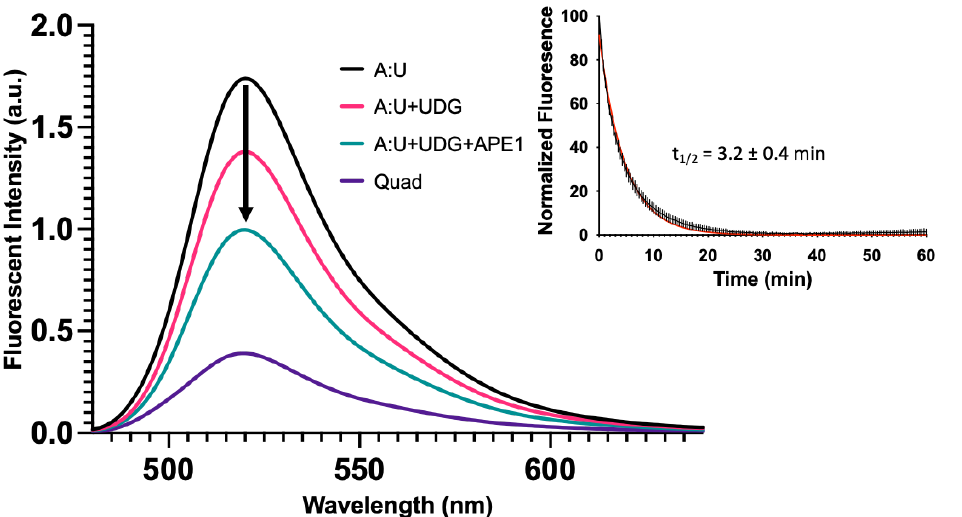
Figure 6. Base excision repair promotes quadruplex formation. In Figure 5, we demonstrated with synthetic oligonucleotides that the presence of a complementary strand containing an abasic site or gap destabilized the duplex and promoted quadruplex formation. Here, we simulated the same process but enzymatically prepared the abasic site and gapped DNA duplex using UDG or UDG and APE1, respectively. The fluorescent emission spectrum was taken for the quadruplex-only strand, duplex oligonucleotide containing a U in the C-rich strand (A:U), duplex [1 µ M] incubated with 10 U of UDG (3.39 pmol, 34 nM), and duplex incubated with 10 U of UDG (3.39 pmol, 34 nM)